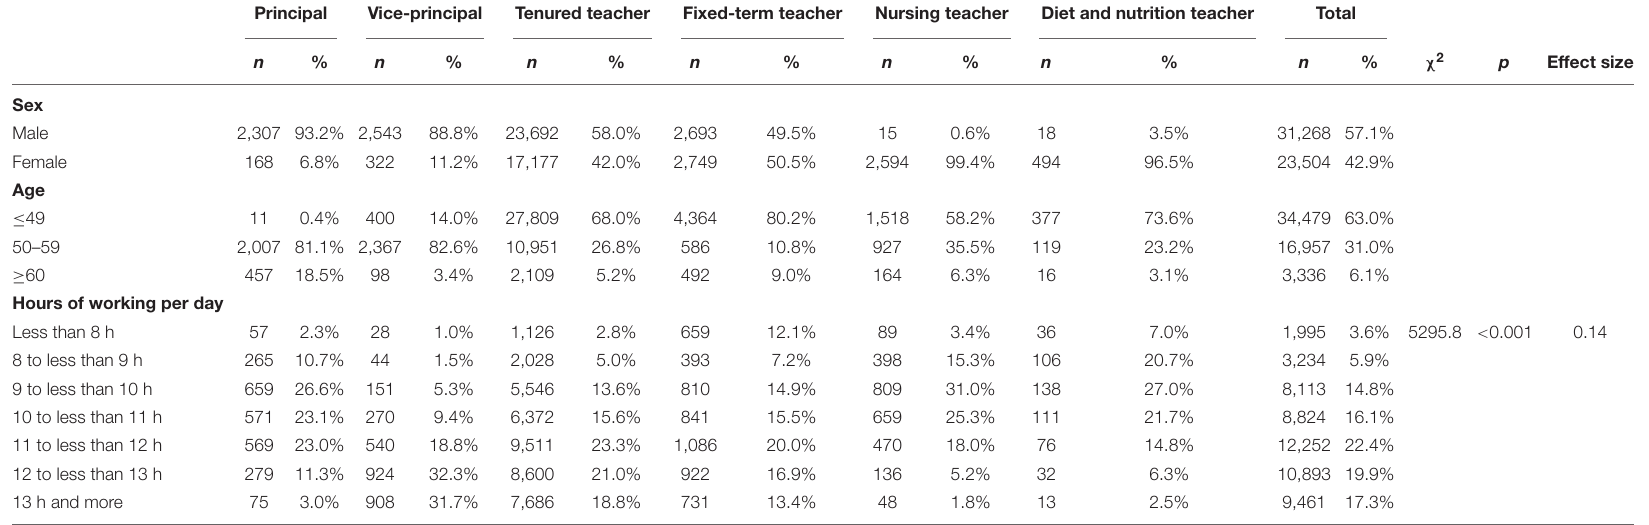
TABLE 2 | Comparisons of working hours per day by job title in junior high school